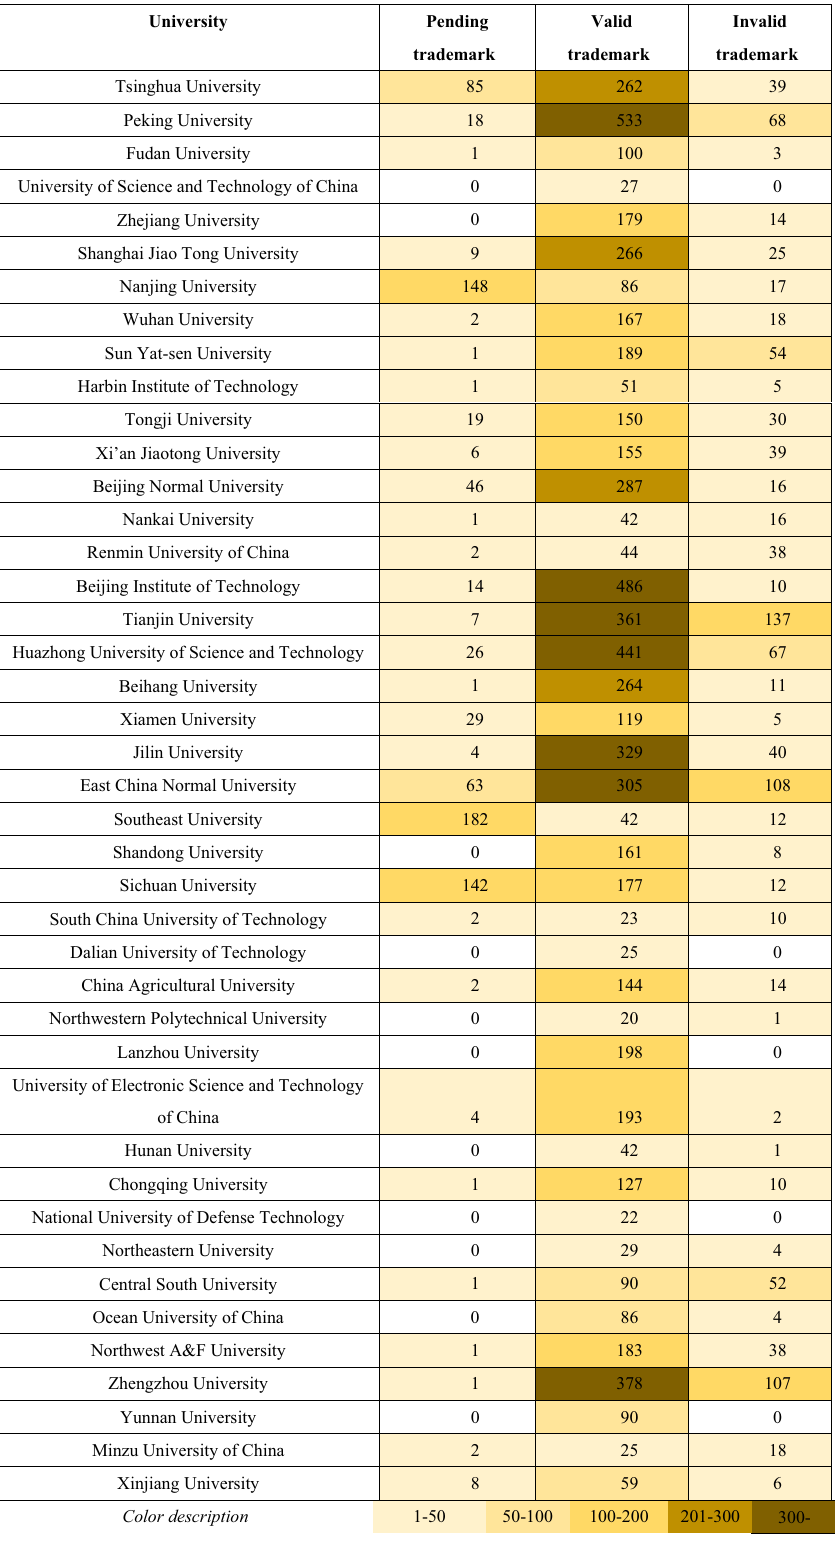
Table 4 The number of trademarks and their legal status for the 42 fi rst-class